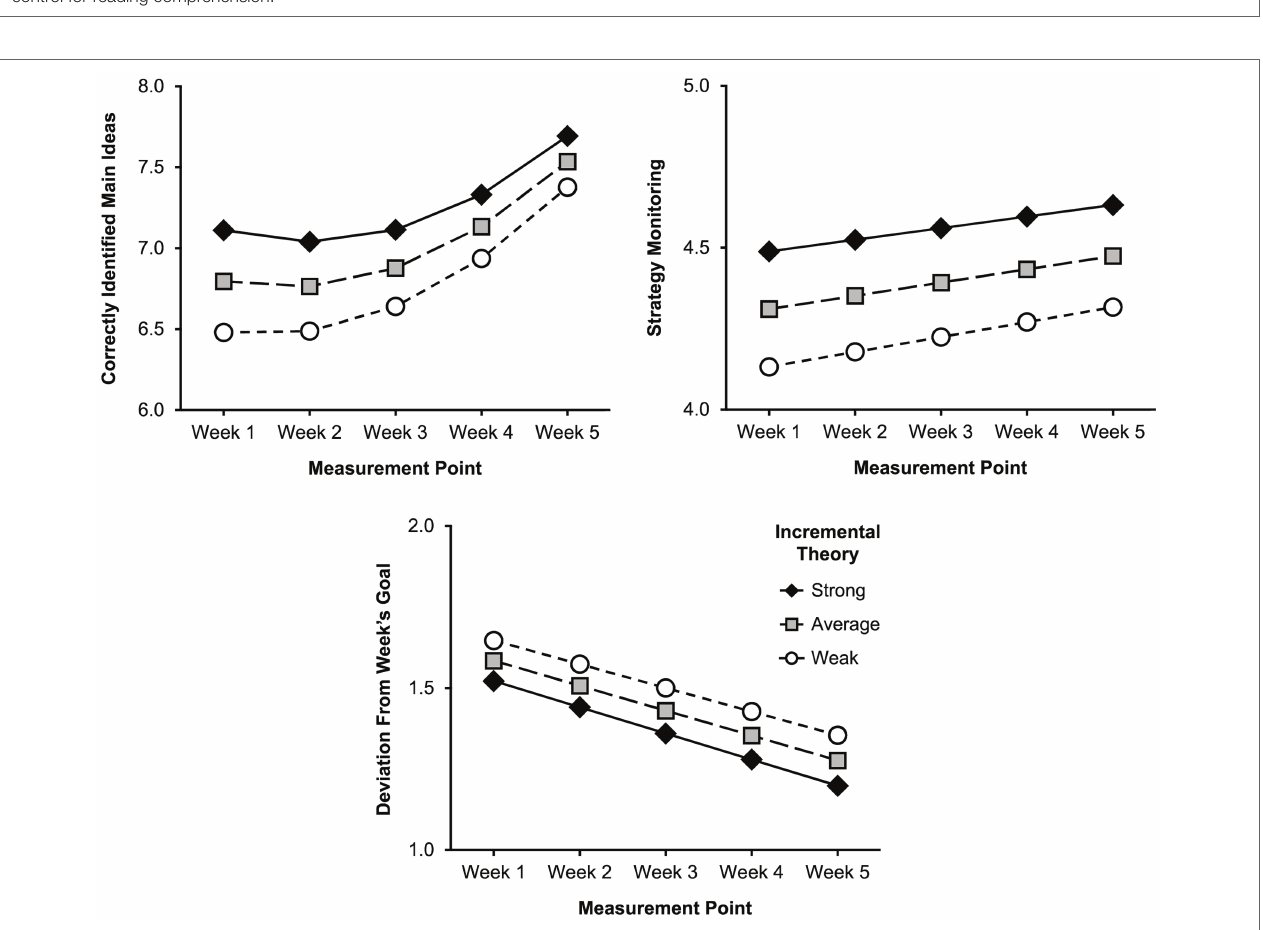
FIGURE 2 | Predicted values for behavior-proximal measures of learning strategy use. The measures were predicted for the baseline week (week 1) and the four proceduralization weeks (weeks 2–5) for different strengths of incremental theory (strong = one SD above the mean, weak = one SD below the mean). Values are based on the models from Table 5 that control for reading